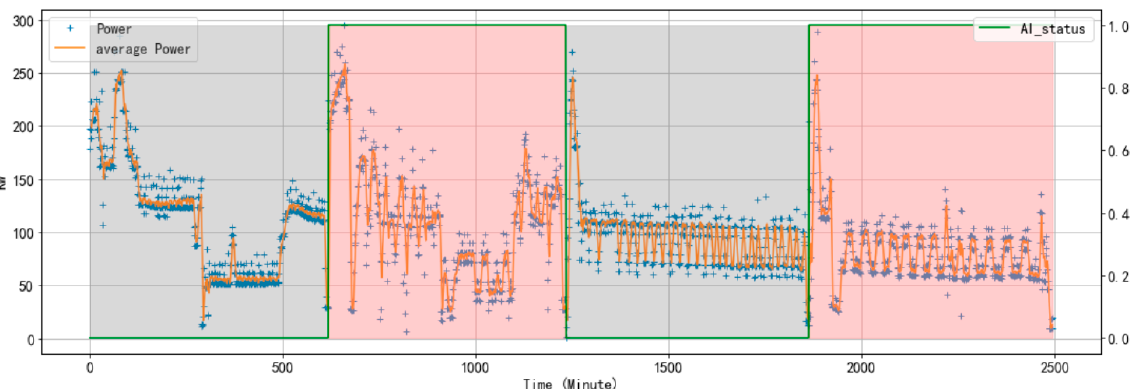
Figure 10. Power trends of AB tests (the grey area represents the AI_status is 0, the red area represents the AI_status is 1).